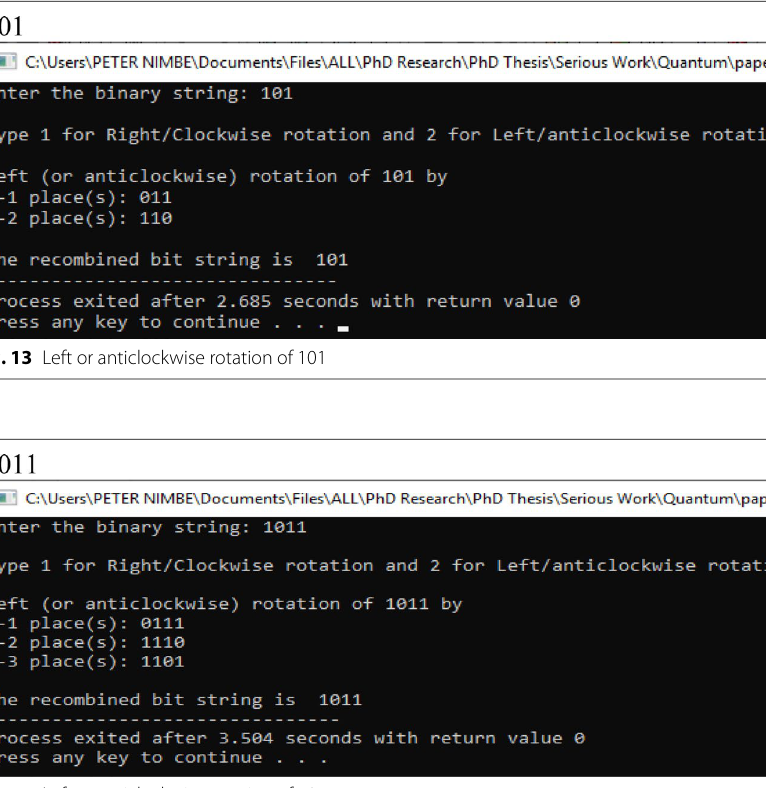
Fig. 14 Left or anticlockwise rotation of 1011